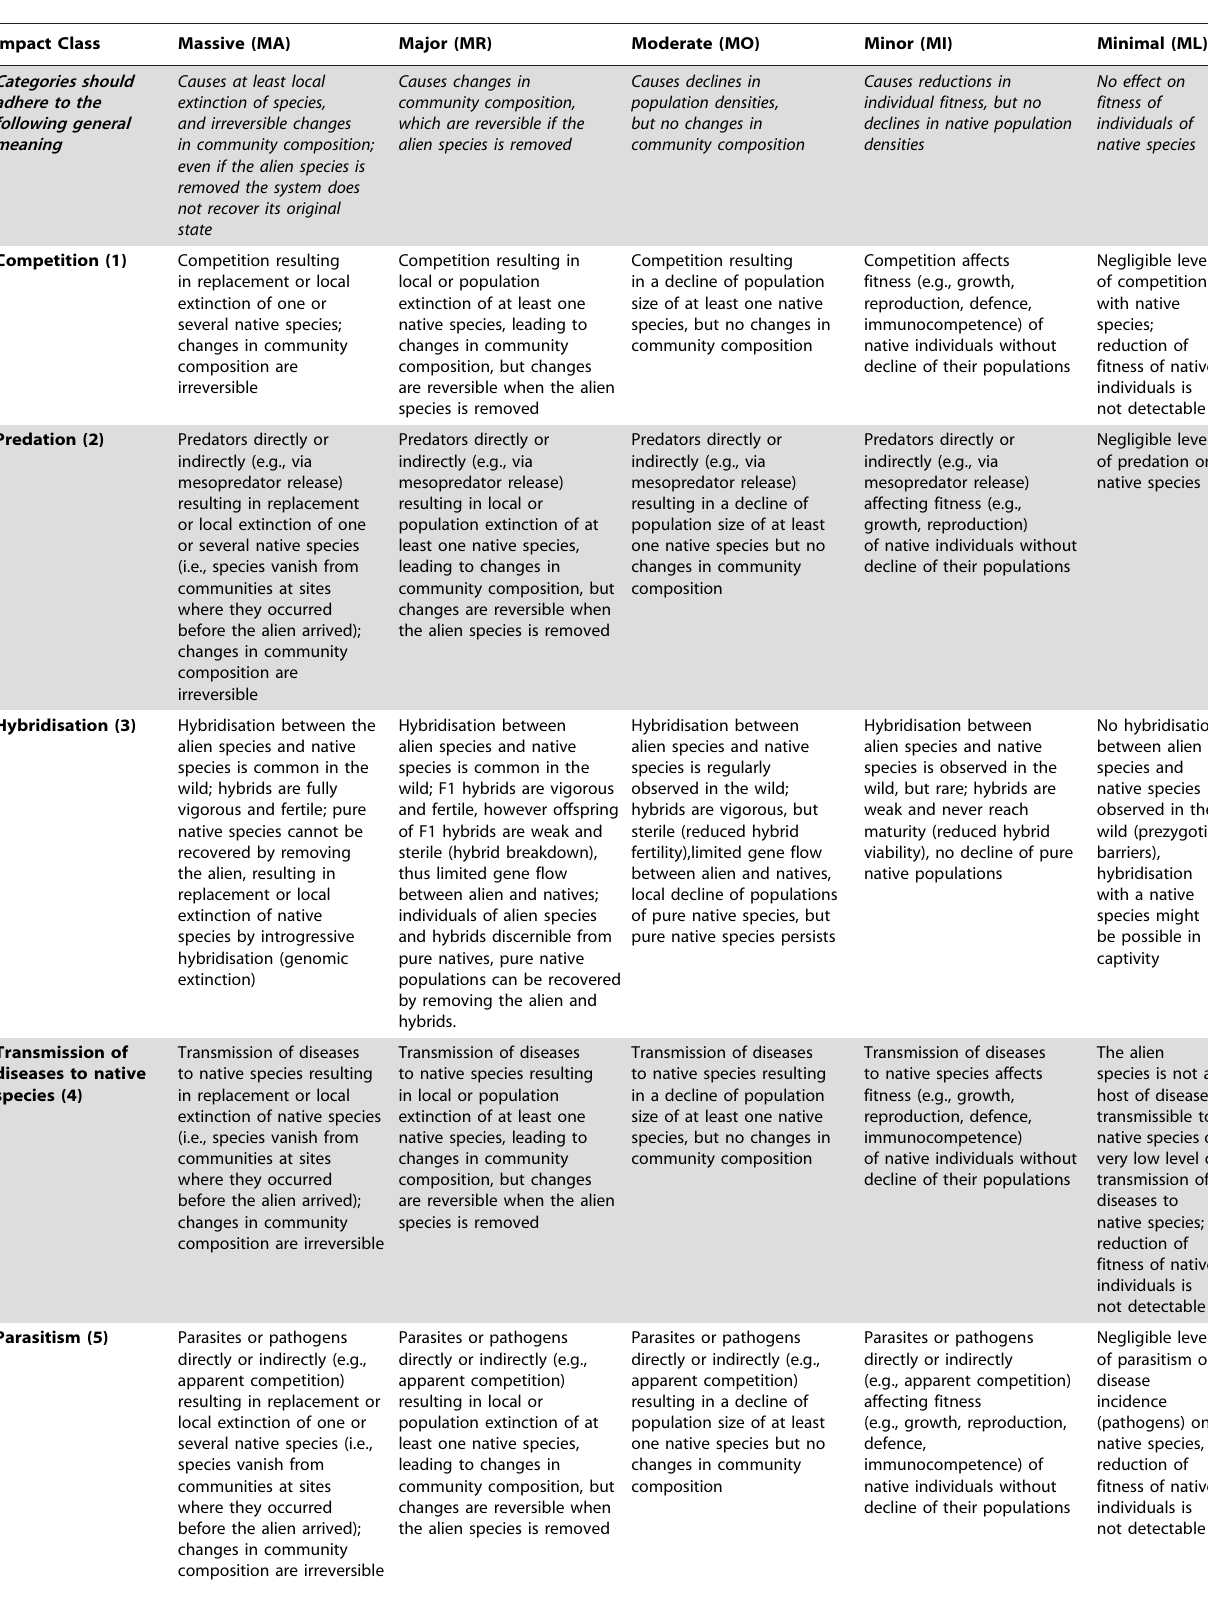
Table 1. Impact criteria for assigning alien species to different categories in the classification scheme (Box 2).